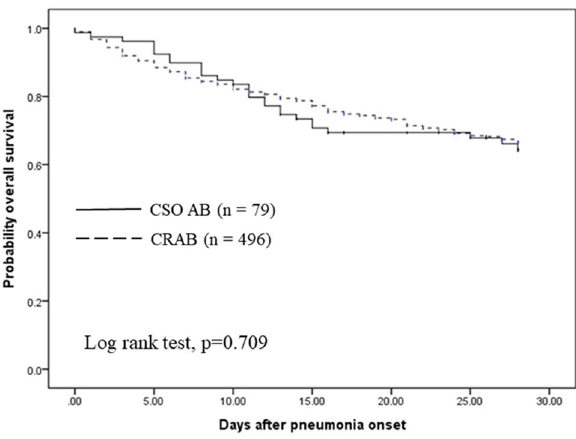
Figure 2. Kaplan–Meier analysis of 28-day survival in patients with CRAB and CSO AB